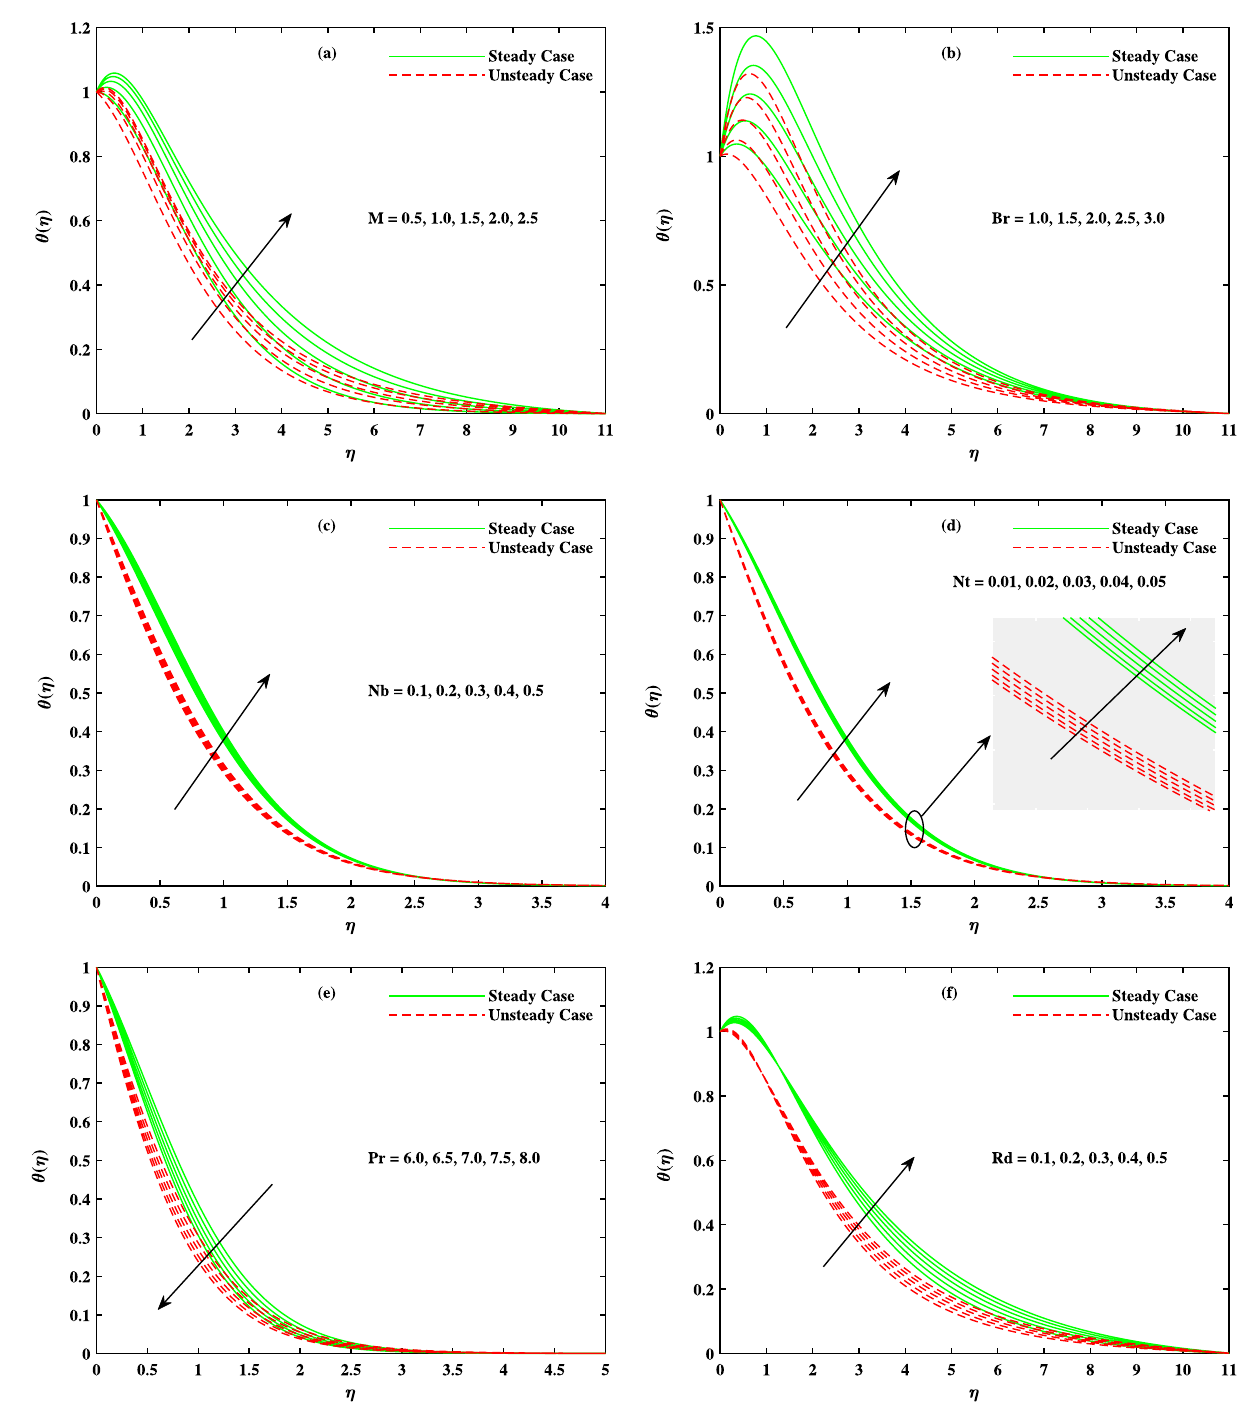
Figure 5. Fluctuation in temperature θ(η) with ( a ) M , ( b ) Br, ( c ) Nb , ( d ) Nt , ( e ) Pr and ( f ) Rd